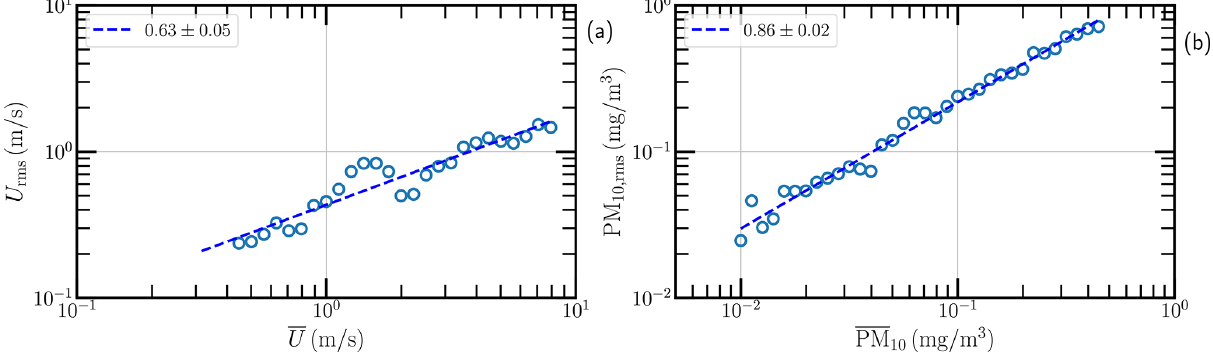
Figure 5. (a) Phase diagram of the hourly averaged wind speed versus the root-mean-square speed at a height of 5m. (b) The hourly averaged concentration PM 10 versus its root-mean-square value. The circle is the bin average value with 10 bins for each decade in the logarithmic